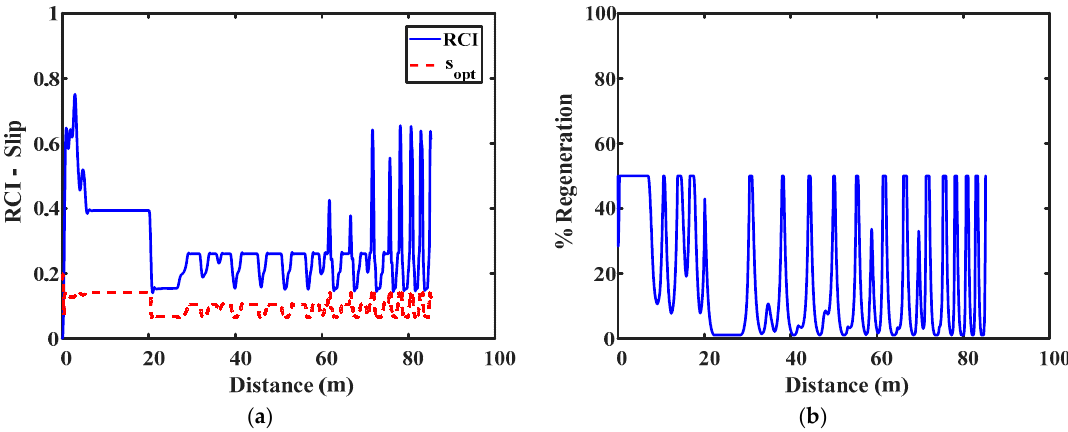
Figure 11. Estimation of road type and optimum slip ( a ) and regeneration rate ( b ).